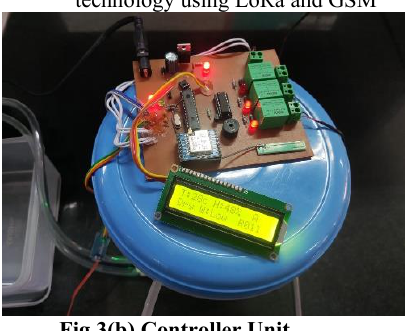
Fig. 3(a) Setup of IoT based wireless data technology using LoRa and GSM